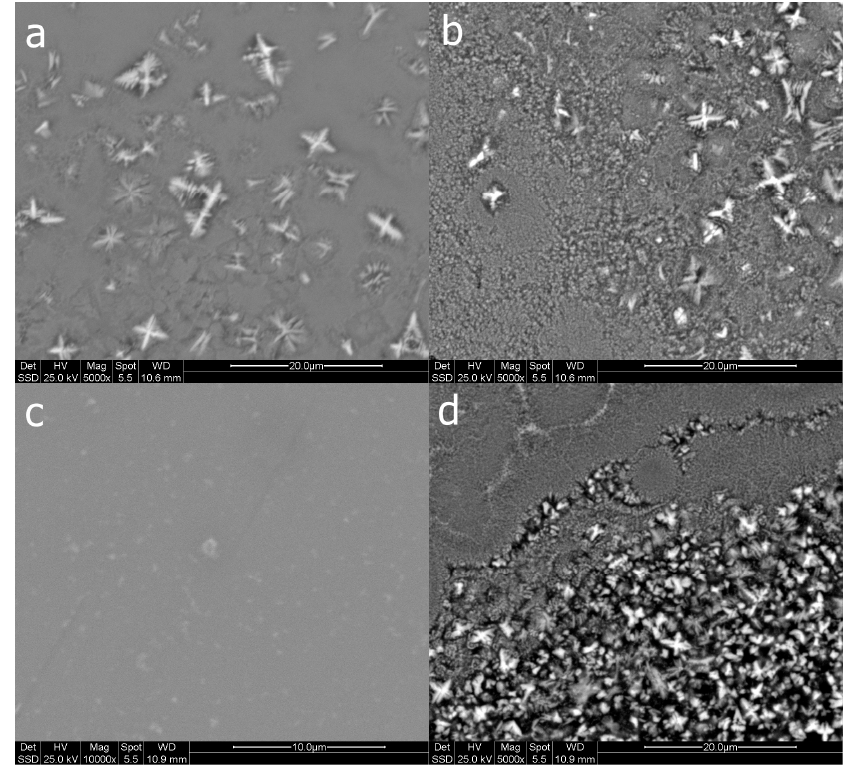
Figure 8. Surface morphology of melt-spun ribbons from Al 79 Si 11 Ni 10 (( a ) as-cast; ( b ) after heat treatment) and Al 67 Si 18 Ni 15 (( c ) as-cast; ( d ) after heat treatment).